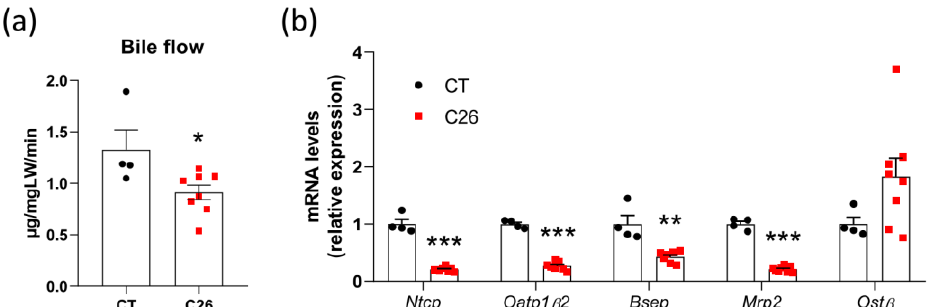
Figure 1. Decreased bile flow and alterations in the hepatobiliary transport system in C26 cachectic mice. ( a ) Bile flow in sham-injected mice (CT; n = 4) and colon carcinoma 26-transplanted mice (C26; n = 8). ( b ) Hepatic mRNA expression levels of genes involved in the hepatobiliary transport system in CT and C26 mice. Ntcp , Na(+)/taurocholate transport protein; Oatp1β2 , organic anion transporter family member 1B2; Bsep , bile salt export pump; Mrp2 , multidrug resistance-associated protein 2; Ost β , organic solute transporter subunit beta. n = 4–8 mice per group; data are presented as mean ± SEM, * p < 0.05, ** p < 0.01, *** p <